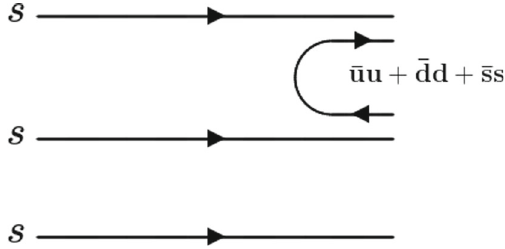
Fig. 1 Flavor structure of the (cid:2) ∗− decay If we assume that in the decays of ϒ( 1 S ) , ϒ( 2 S )